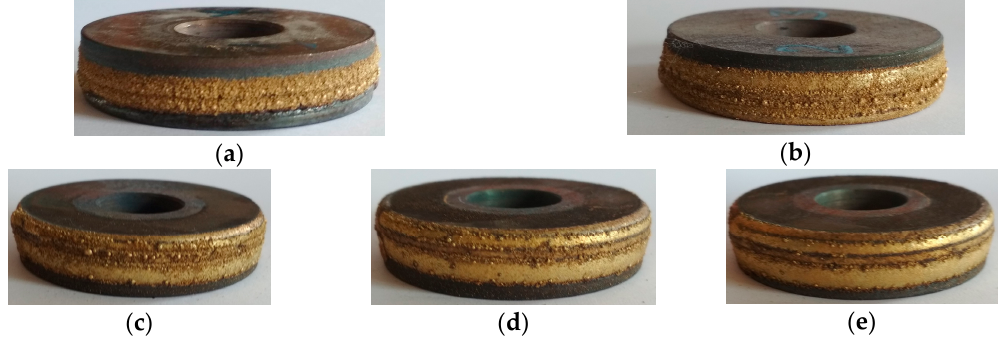
Figure 1. The appearance of the bronze coating obtained for samples: ( a ) No. 1; ( b ) No. 2; ( c ) No. 3; ( d ) No. 4; ( e ) No. 5. The outer diameter of all the rollers is 45 mm.